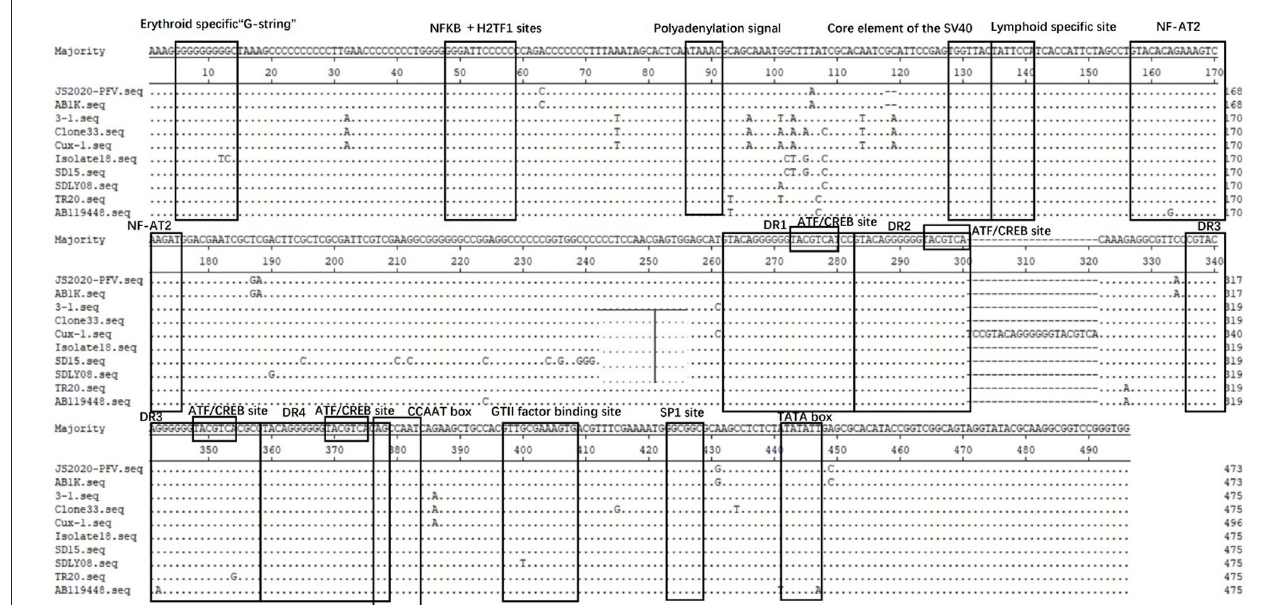
FIGURE 4 | Structural analysis of the non-coding region of JS2020-PFV strain and reference strains. The sequences in black frames are the motifs of transcriptional regulatory elements in this